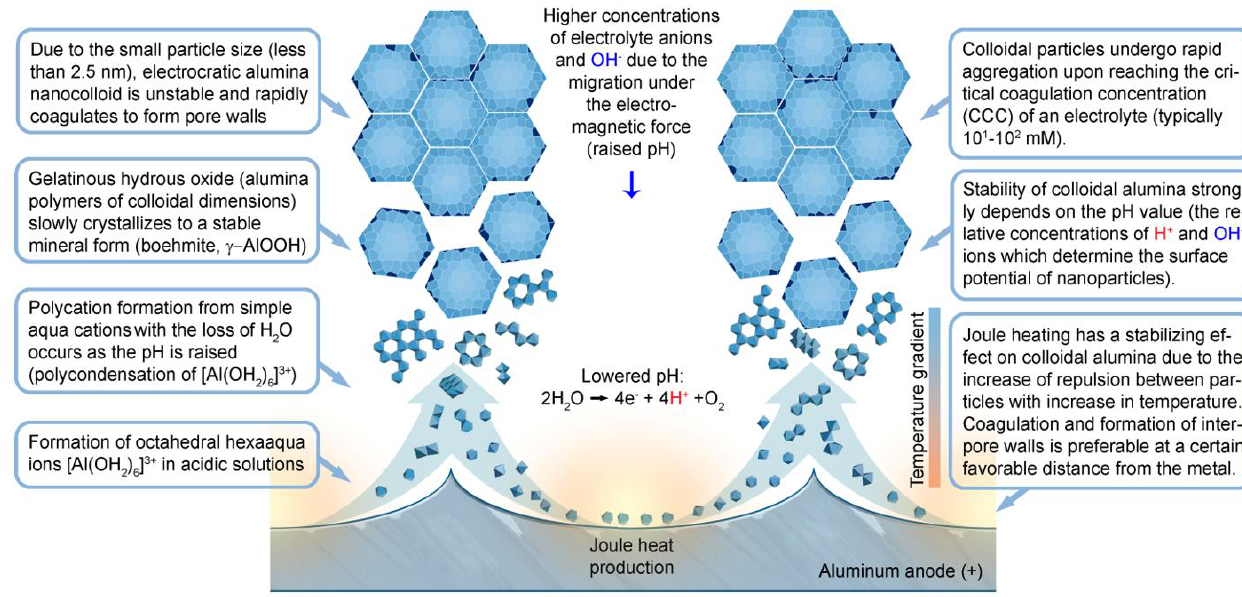
Figure 15. Schematic representation of the mechanism of polycrystalline PAA growth and explanation of the factors associated with the stability of colloidal alumina dispersion. The formation of simple [Al(H 2 O) 6 ] 3+ aqua cations is followed by their polycondensation into polyoxo compounds (with elimination of H 2 O molecules) and then the nucleation of hydrated polymeric alumina particles. These colloidal particles are capable of coagulation and forming the interpore walls. The stability of particles toward aggregation is determined by a synergistic effect of multiple opposing factors: the increased temperature (due to Joule heating) and the decreased pH value in the proximity of the anode surface are likely to stabilize the dispersion, whereas the small particle size and the increased concentration of the indifferent electrolyte anions (due to their Coulomb attraction to the anode) should cause rapid coagulation.